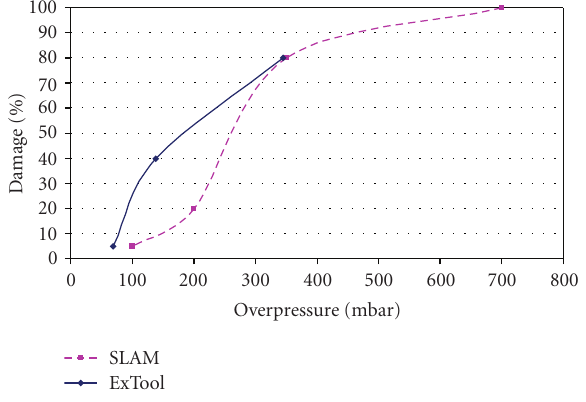
Figure 4: Comparison of threshold values.